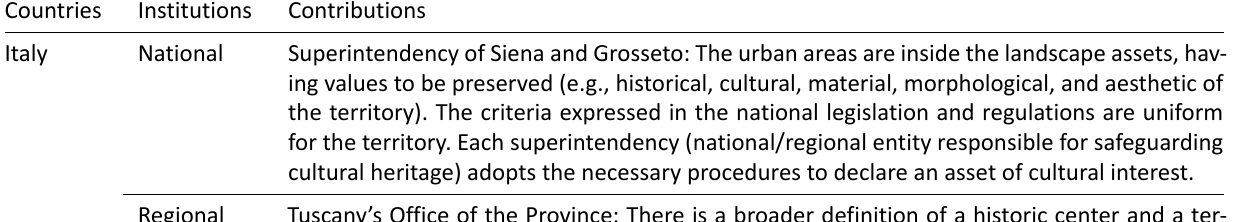
Table 3. Institutional stakeholders’ contributions to building regulations concerning urban